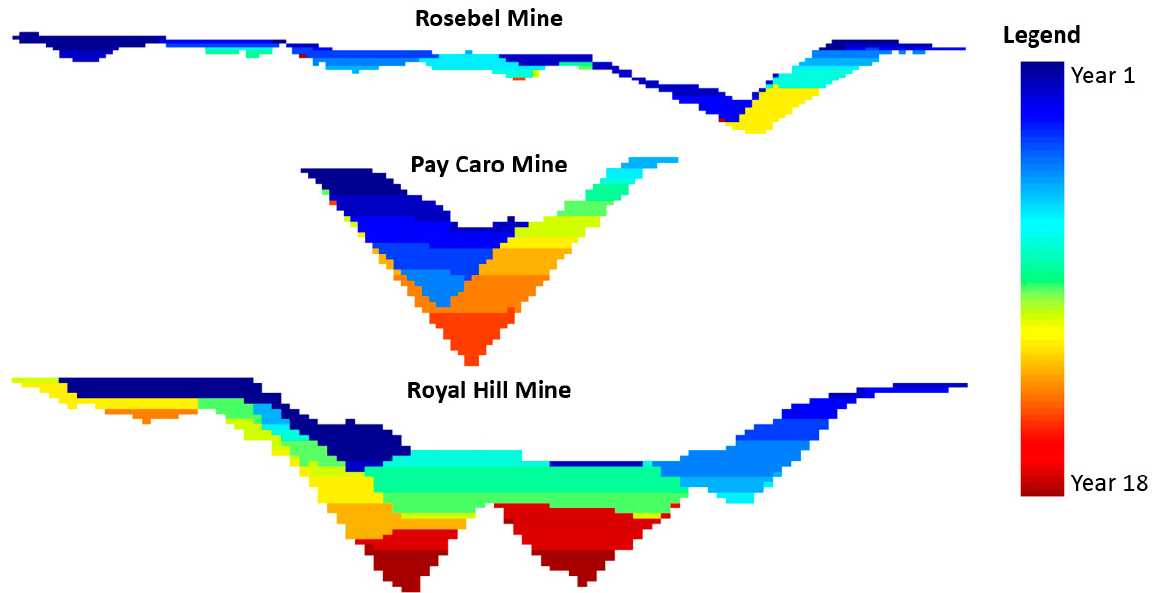
Figure 5. Stochastic life-of-asset production schedules at the three mines at the RGM mining complex.